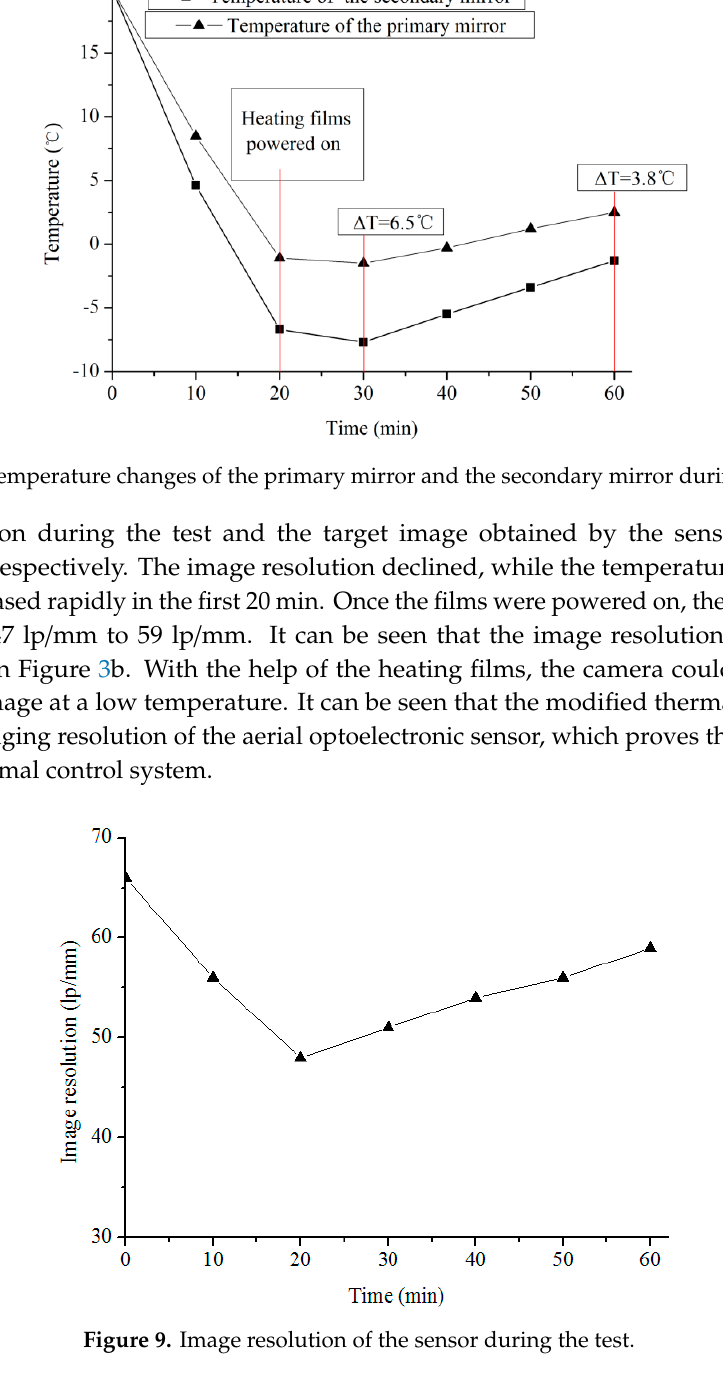
Figure 9. Image resolution of the sensor during the test.